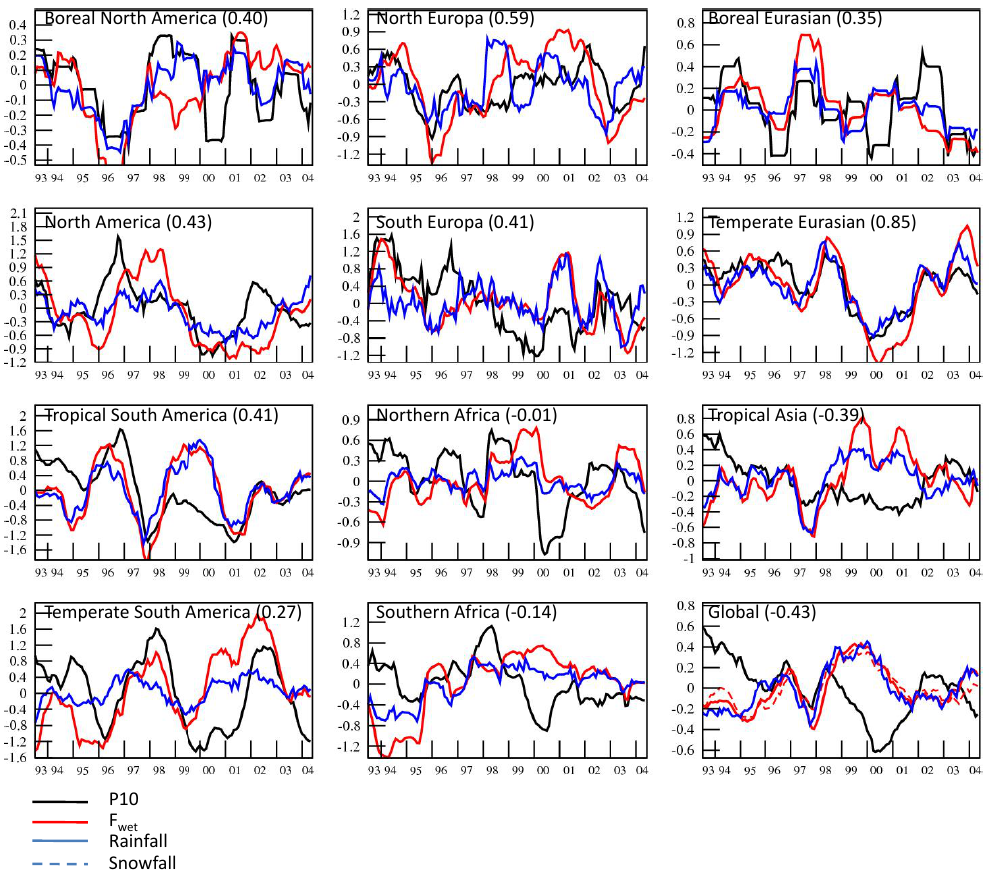
Fig. 8. Year-to-year variability of P10, F max and of snowfall + rainfall. Each curve is obtained using moving average over 12 month on monthly anomalies. These anomalies were obtained by removing the mean seasonal cycle over 1993–2004 then dividing by the maximum value. Correlation between P10 and F wet is given between brackets in each region’s